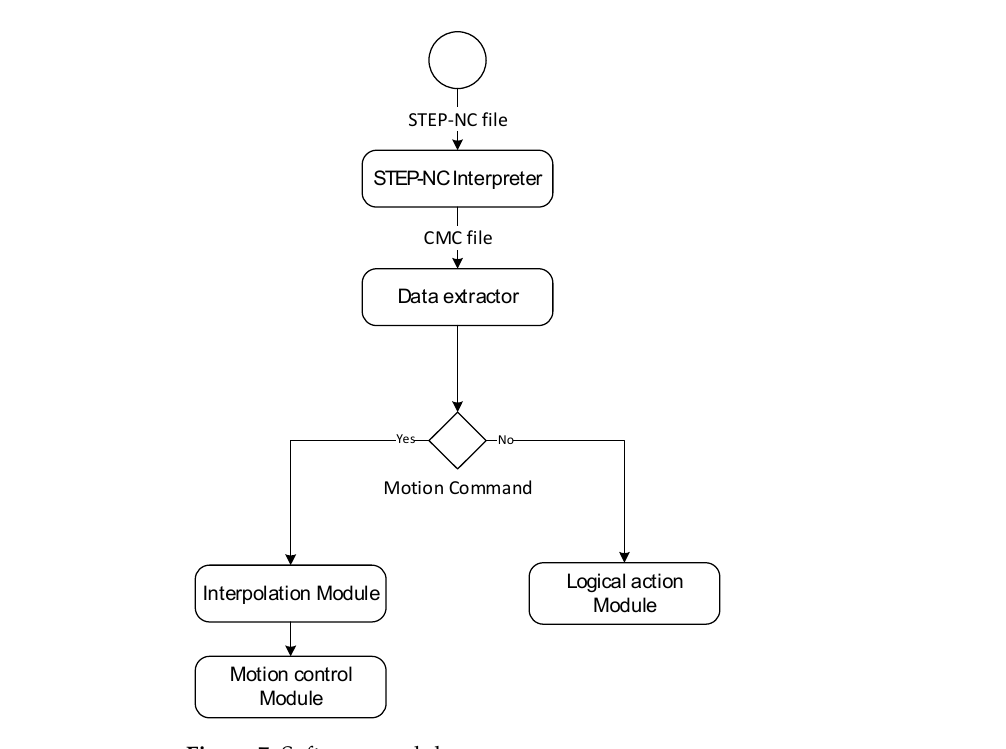
Figure 7. Software modules.